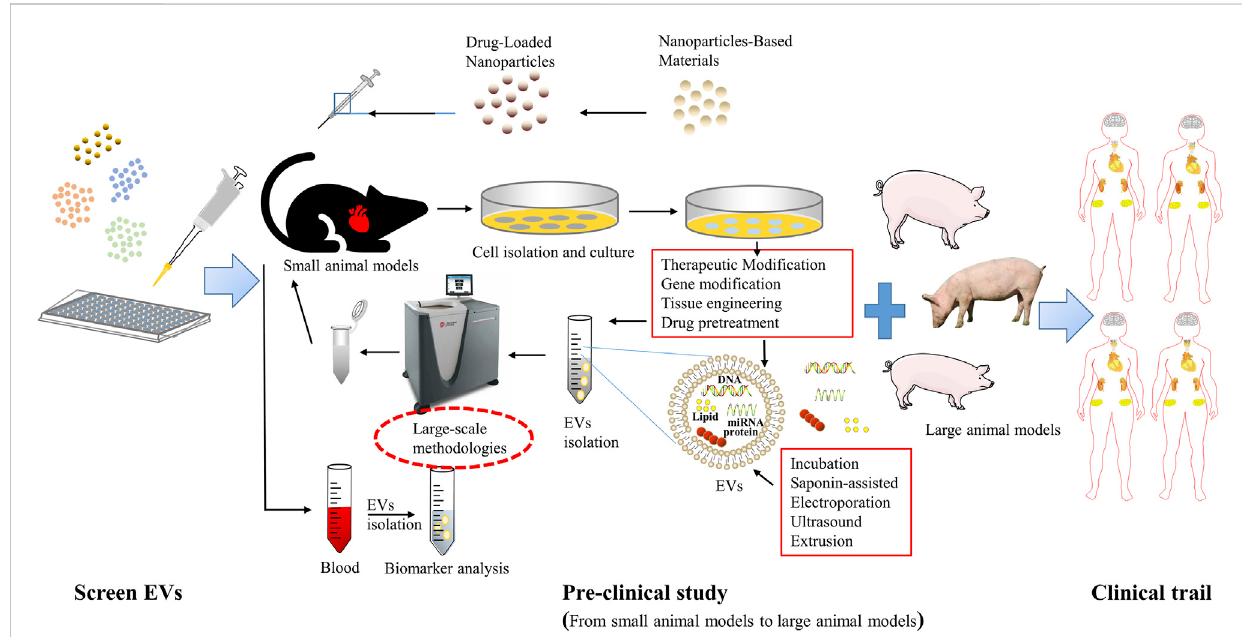
FIGURE 3 Extracellular vesicle-based therapeutics toward clinical application. The fi rst is abasic study to identify potential EVs, followed by preclinical studies, includingsmallanimal invivo trialsandlargeanimal invivo trials,aswellasresearchestoevaluatethemanufacturingprocess,qualitycontrol,andstability (CMC); and fi nally a phase III randomized clinical trial to further evaluate its safety and ef fi